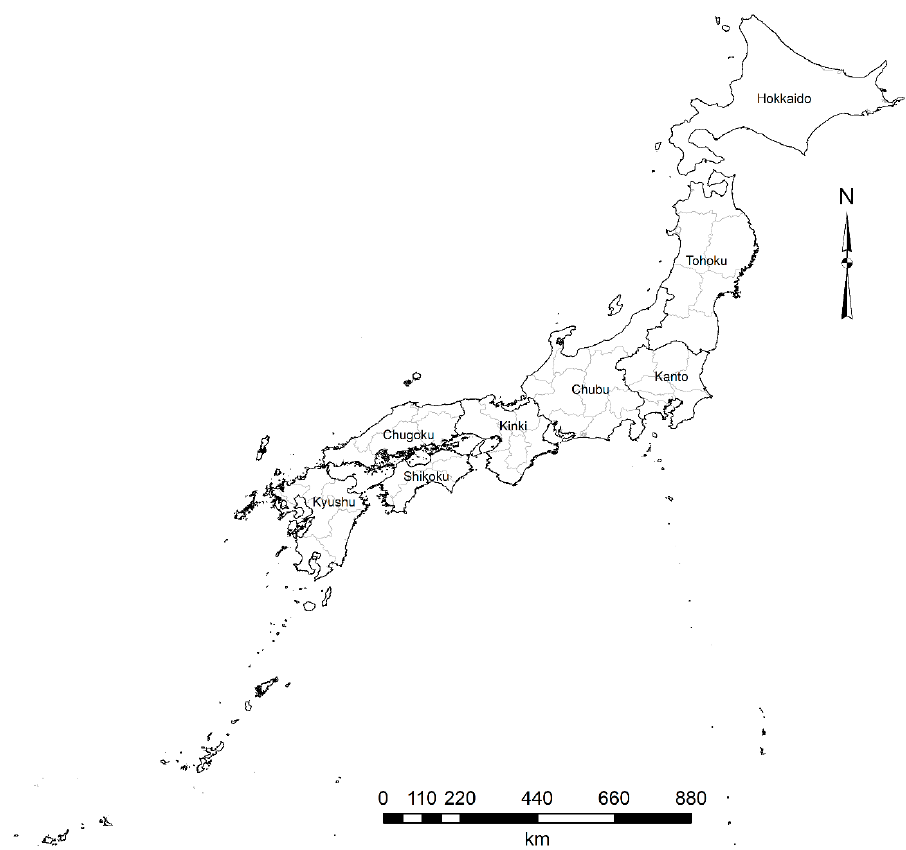
Figure 1. Japan by regions and prefectures.